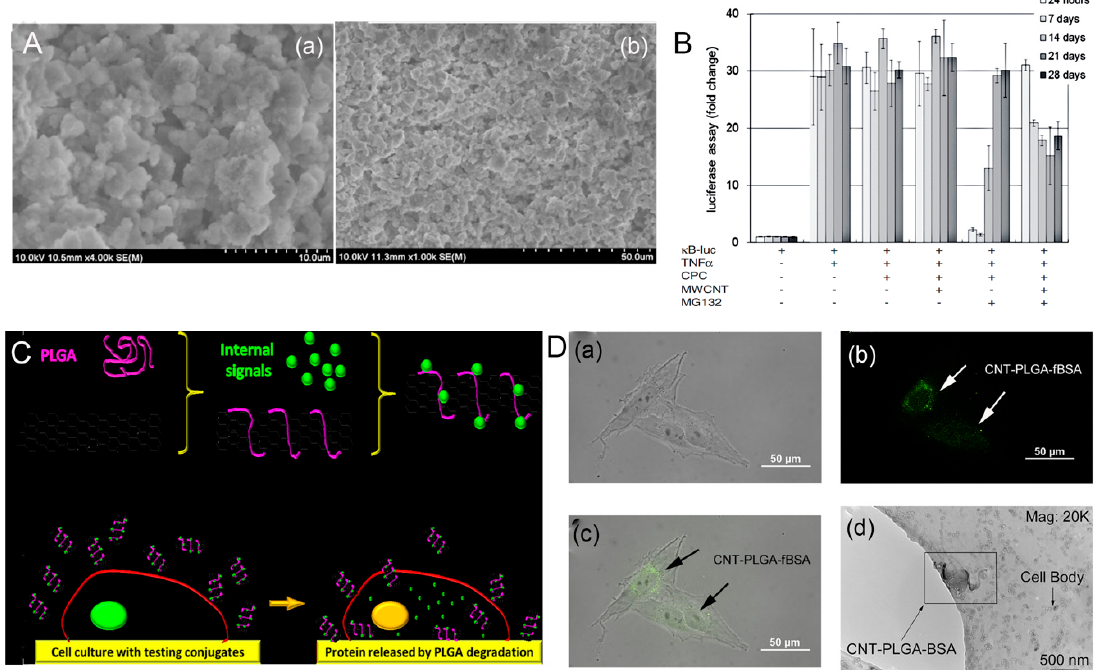
Figure 10. Carbon nanotube (CNT)-based delivery systems for peptides and proteases. ( A ) SEM images of calcium phosphate cement (CPC)–MWCNT–Z-Leu-Leu-Leu-al (MG132). ( B ) The luciferase assay shows that MG132 released from CPC or CPC–MWCNT inhibited TNF- α -induced NF- κ B activation and osteoclast di ff erentiation. ( C ) Schematic diagram of CNT–poly(lactide-co-glycolide) (PLGA) conjugate fabrication and cell-to-cell delivery. ( D ) Penetration of CNT–PLGA–proteins into osteosarcoma cells cultured in CNT–PLGA–fBSA (fluorescent bovine serum albumin) ( a , b ) and CNT–PLGA–BSA penetrating the osteosarcoma cell ( c , d ). Reproduced with permission from [230,233]. Elsevier, 2014; PLOS: Open Access, 2013. Table 2. Applications of CNT composites as nanocarriers for bone tissue regeneration and engineering.